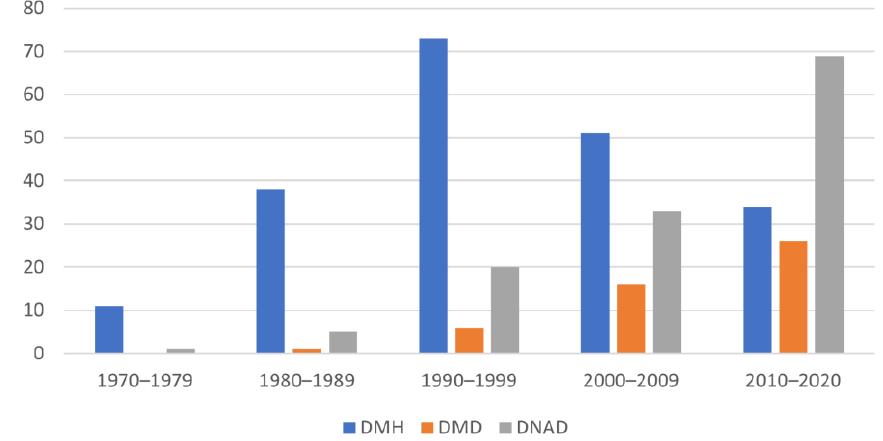
Figure 6. Studies found in each database, allocated into three categories, and distributed in the considered decades. It is interesting to note the increased number of studies carried out on dogs with a spontaneous disease in the last decades compared to studies in which the dog was a model for testing drugs potentially useful for the treatment of human CHF.